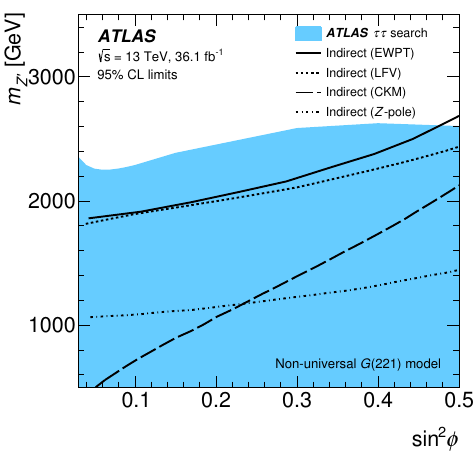
Figure 11. The 95% CL exclusion in the non-universal G (221) parameter space overlaid with indirect upper limits at 95% CL from (cid:12)ts to electroweak precision measurements [144], lepton (cid:13)avour violation [145], CKM unitarity [146] and Z -pole measurements